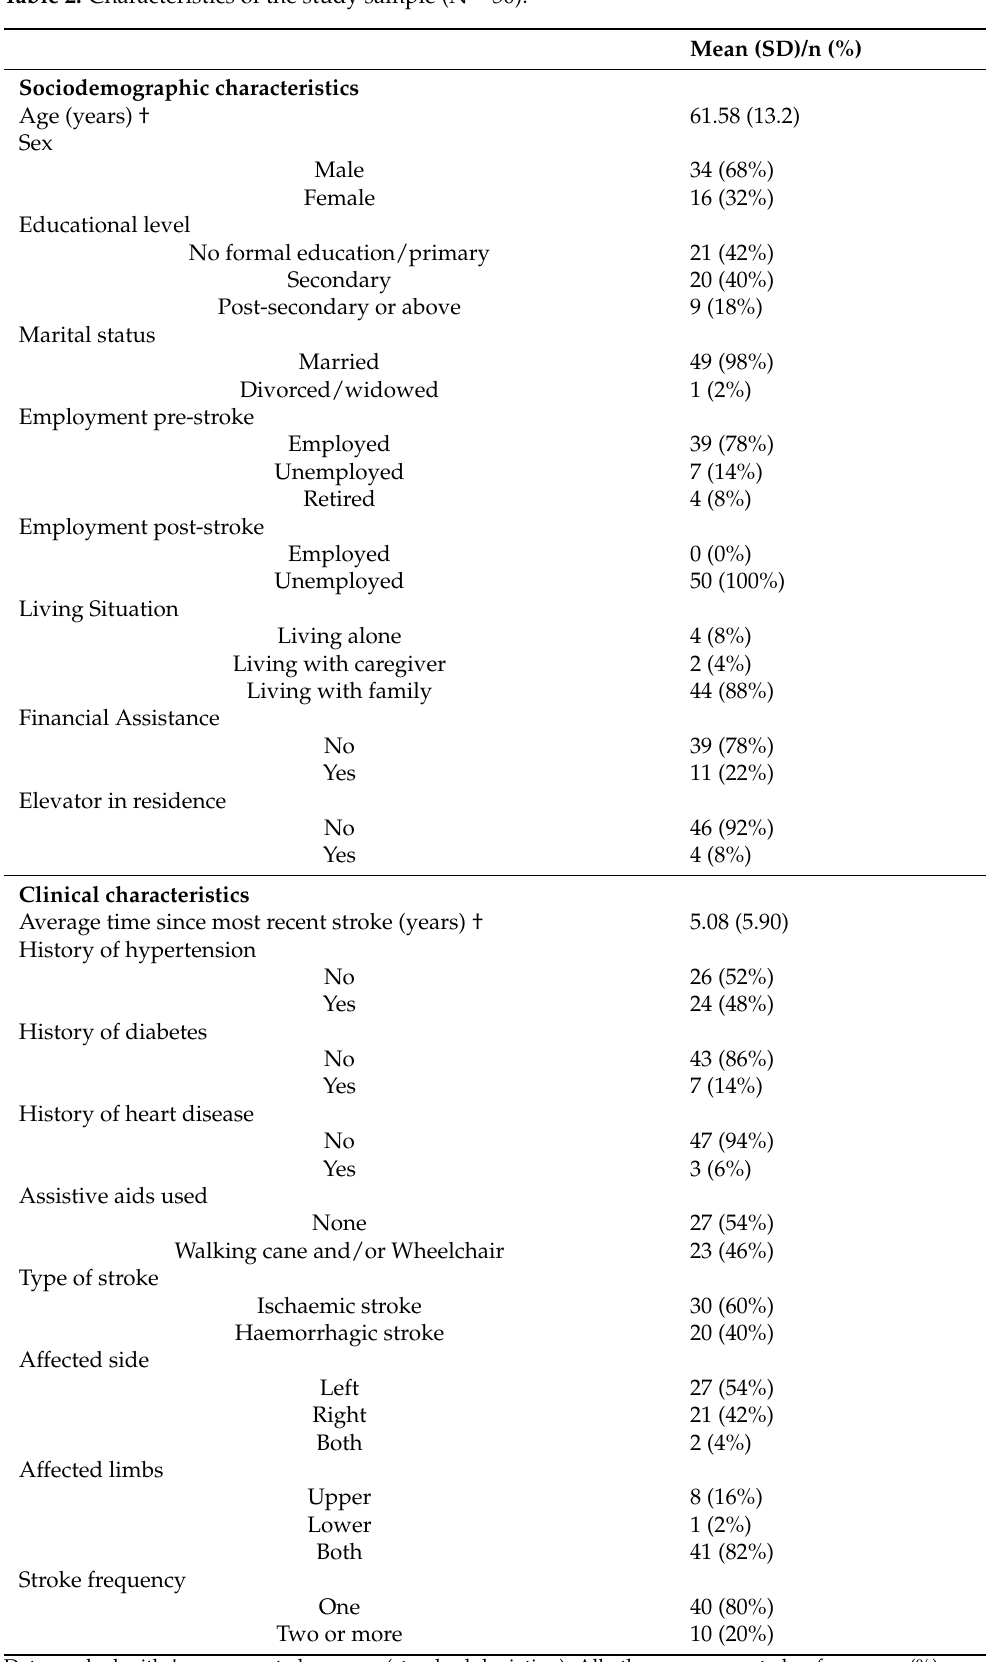
Table 2. Characteristics of the study sample (N =